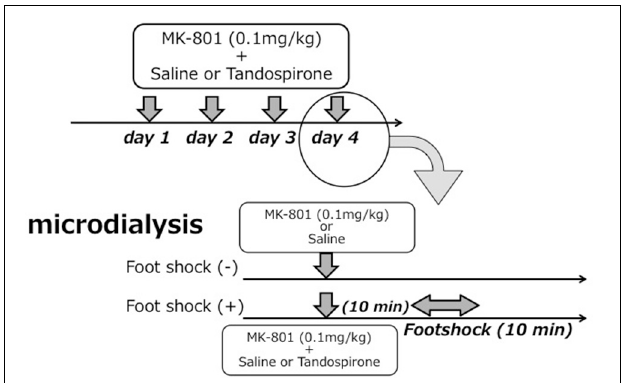
FIGURE 1 | Schematic representation of the experimental protocol for microdialysis experiments. Upper parts in each figure reveals drug treatment for 4 days and lower parts time course in the 4th day (experiment